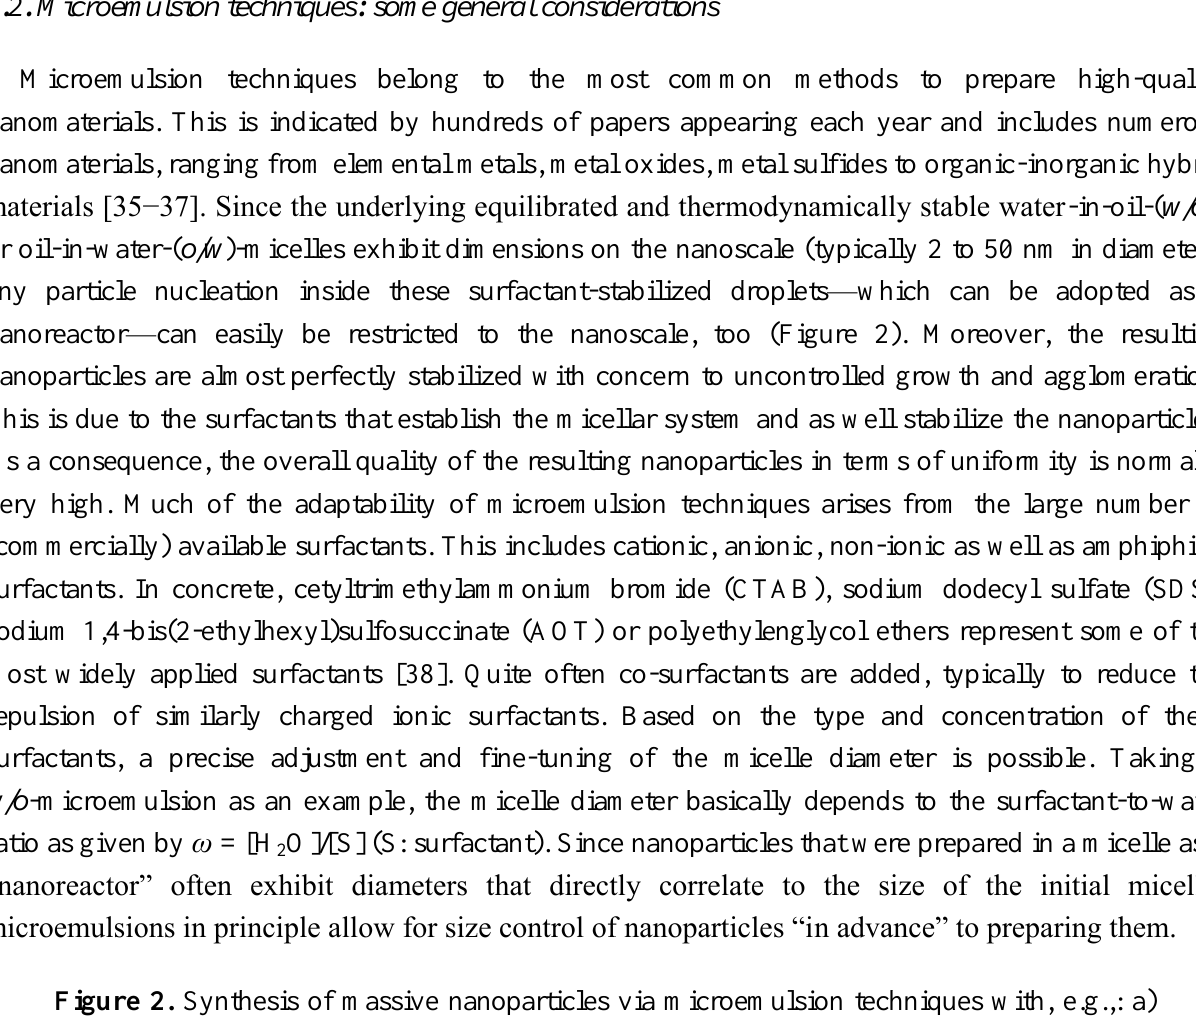
Figure 2. Synthesis of massive nanoparticles via microemulsion techniques with, e.g.,: a) mixing and coalescence of two different w/o -micellar systems, each of them containing a starting material A and B; b) thermal initiation of particle nucleation in a single w/o - micellar system containing two reactants A and